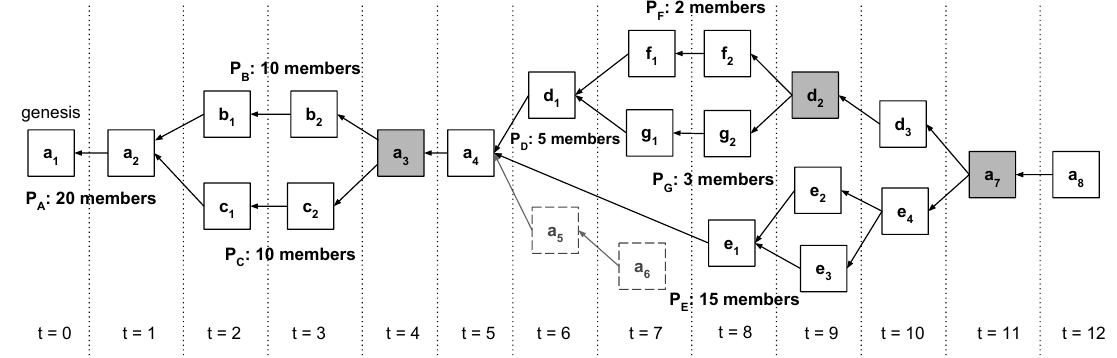
Fig. 1. Example SwarmDAG ledger when network partitions occur and merge. Details of the sequence of events leading up to this example ledger is described in Section